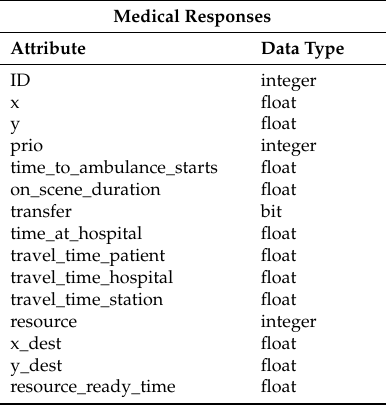
Table 3. Data used from the medical response dataset after